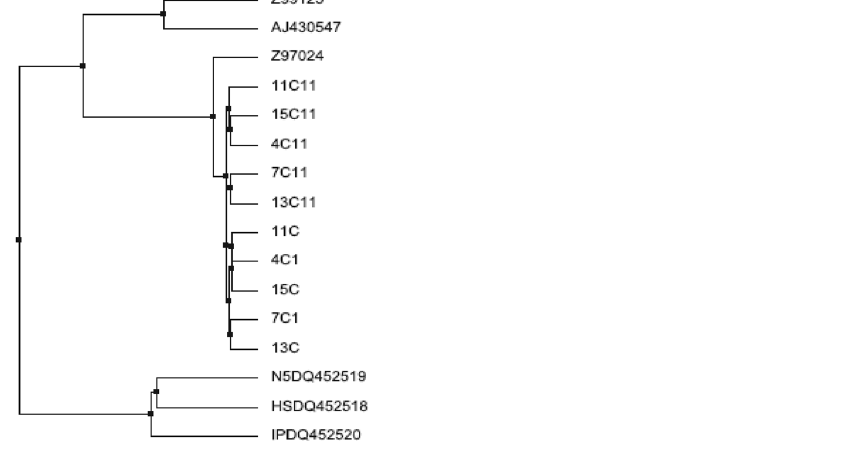
Figure 2. Phylogenetic diversity of isolated strains using multiple sequence alignments of sequences sbo and flanking region.